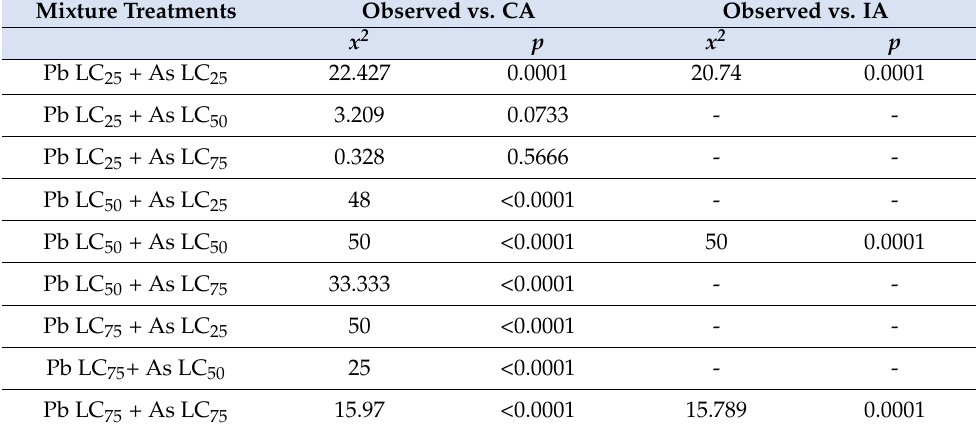
Table 3. Chi-square contrast of regression models for observed mixture exposure and concentration addition (CA) and independent action (IA) models.